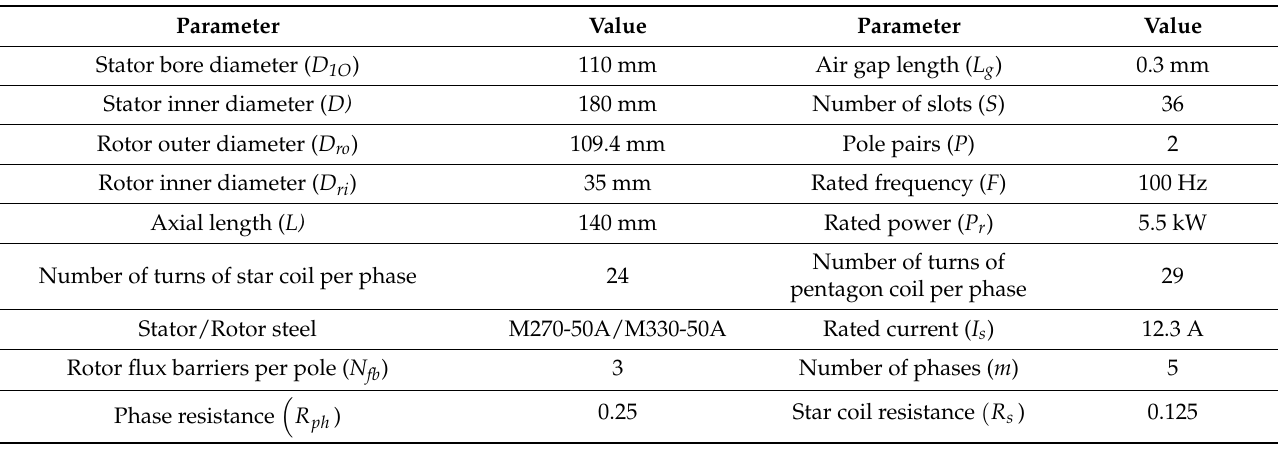
Table 1. The five-phase SynRM geometrical parameters.